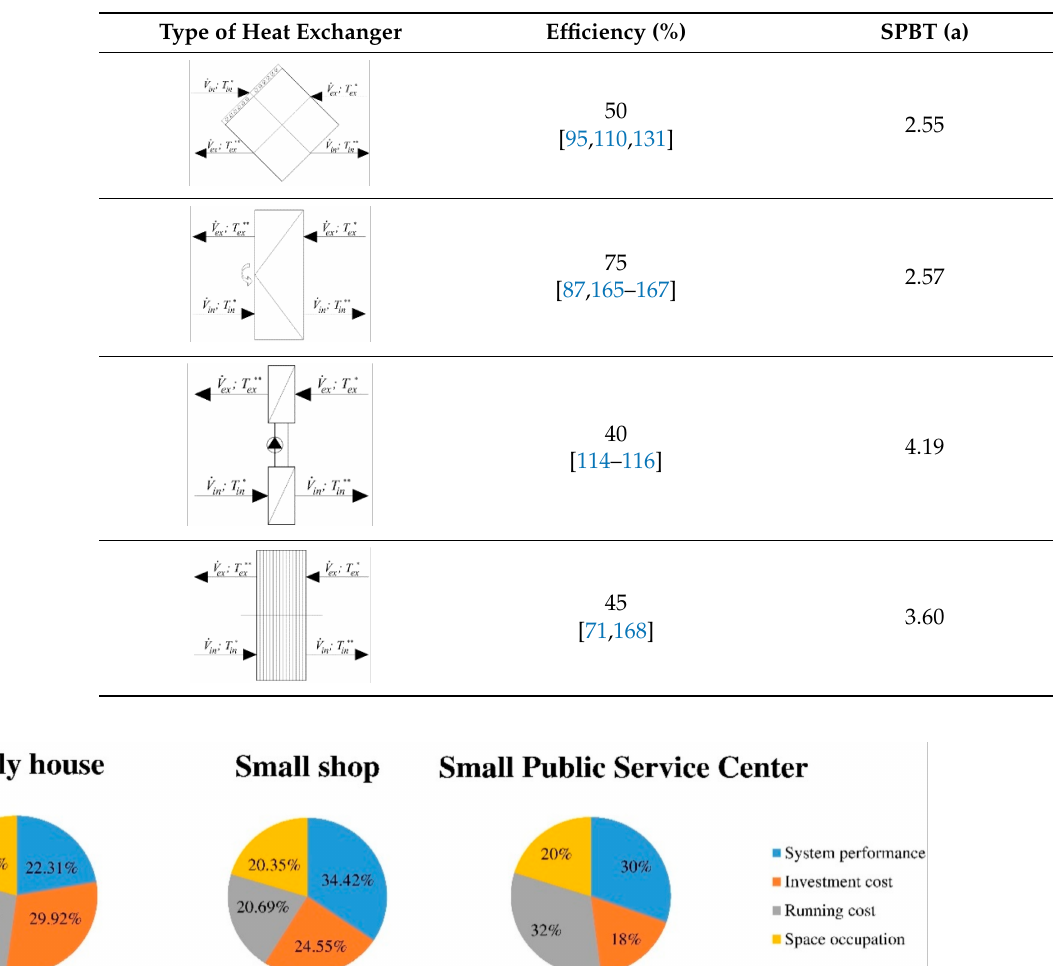
Table 4. Comparison of heat recovery efficiency and SPBT for four types of heat recovery exchangers.